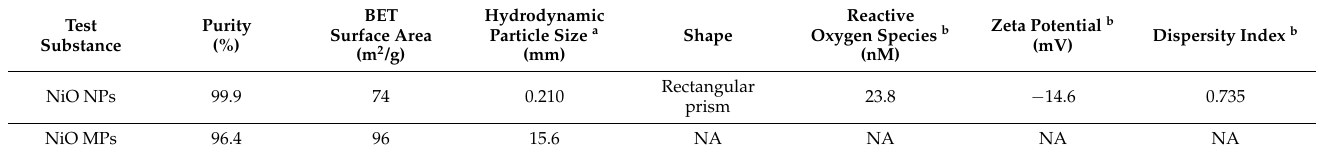
Table 1. Physico-chemical characteristics of the NiO test